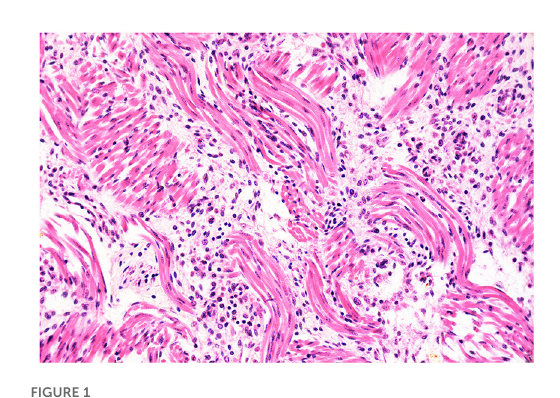
FIGURE2 Histopathology of the placenta. Placentitis. The chorionic stroma is expanded by edema and infiltrated by moderate numbers of lymphocytes and histiocytes. The trophoblastic epithelium is effaced and replaced by hypereosinophilic and karyorrhectic sloughed cellular debris, indicating severe necrosis. H&E stain, original magnification